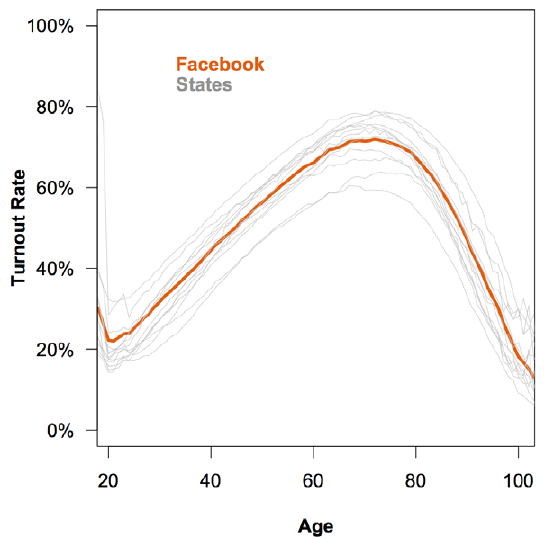
Figure 5. The proportion of matched users who turned out to vote by age. The dark line represents the turnout rate by age of the matched sample of Facebook users. Each gray line represents the turnout rate by age of a state voter record. The results show that users on Facebook exhibit the same pattern of turnout with respect to age as the populations of each state.